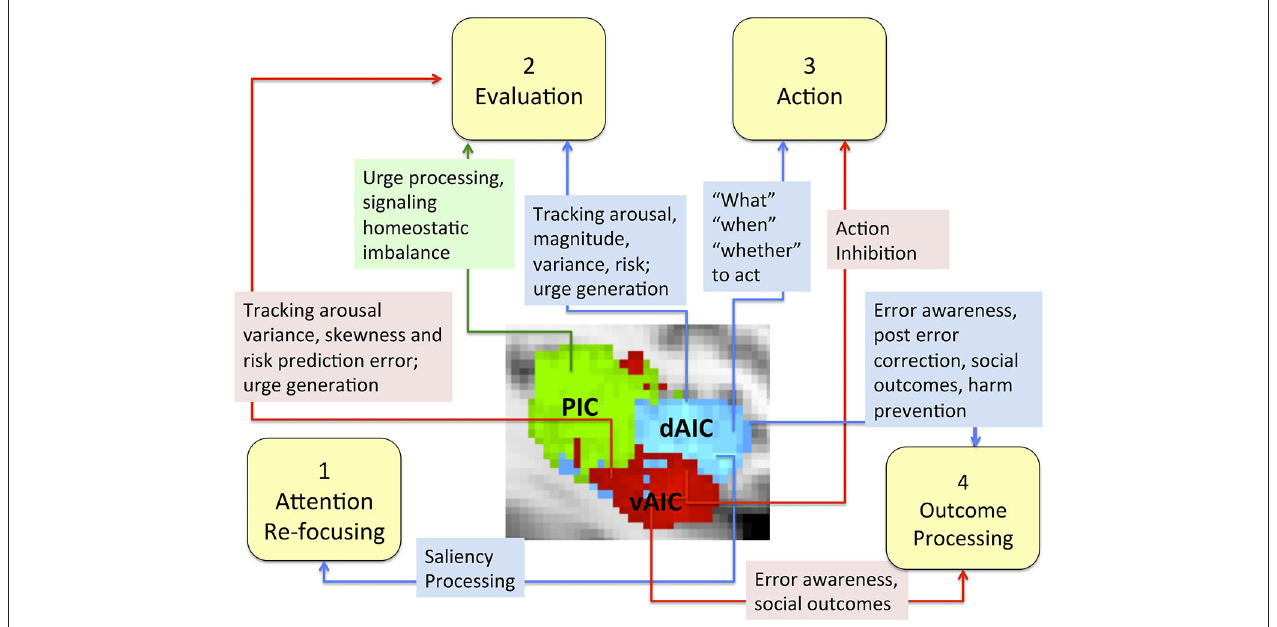
FIGURE 7 | The role of the IC and its sub-regions in each phase of decision-making. Sub-regions of the Insula: posterior (green), dorsal anterior (blue) and ventral anterior (red).